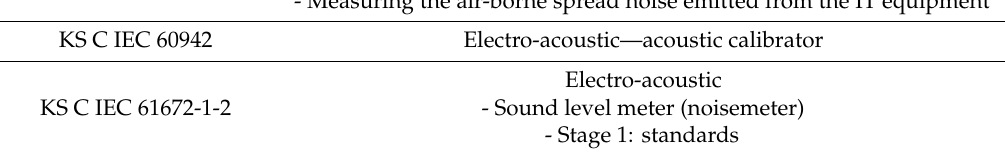
Table 3. The direction estimating algorithm .